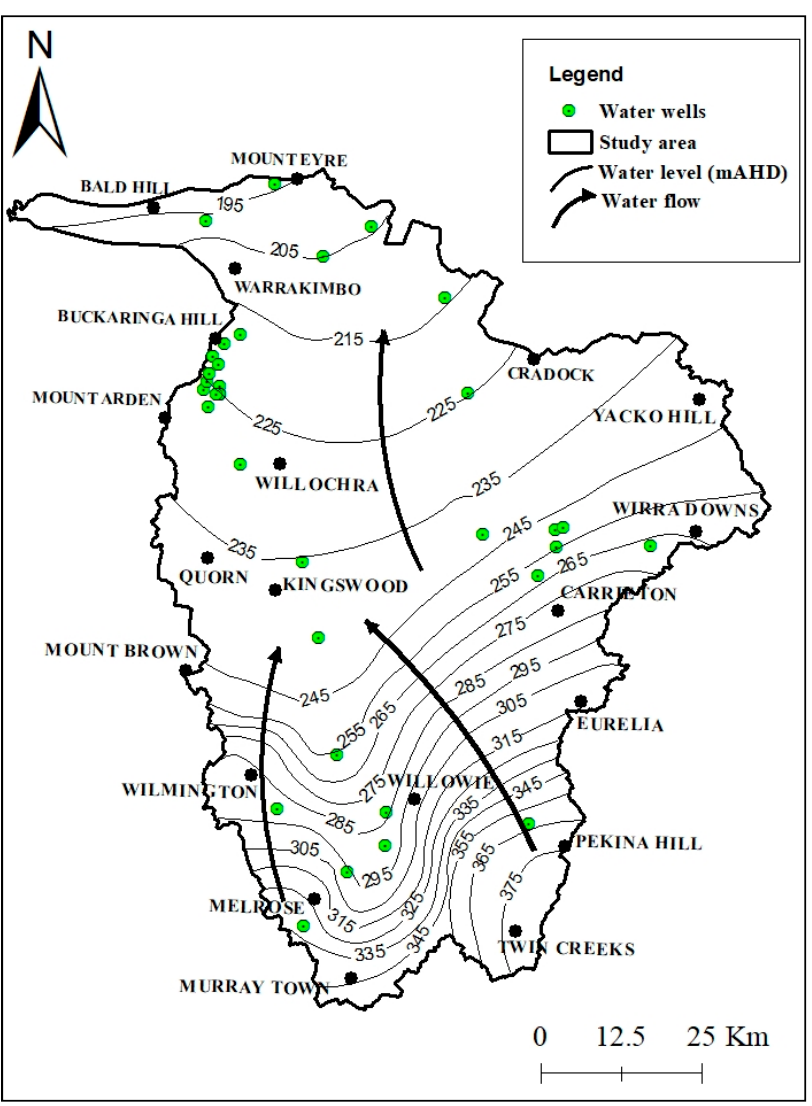
Figure 4. Groundwater flow distribution for the Tertiary confined aquifer in the study area [53]